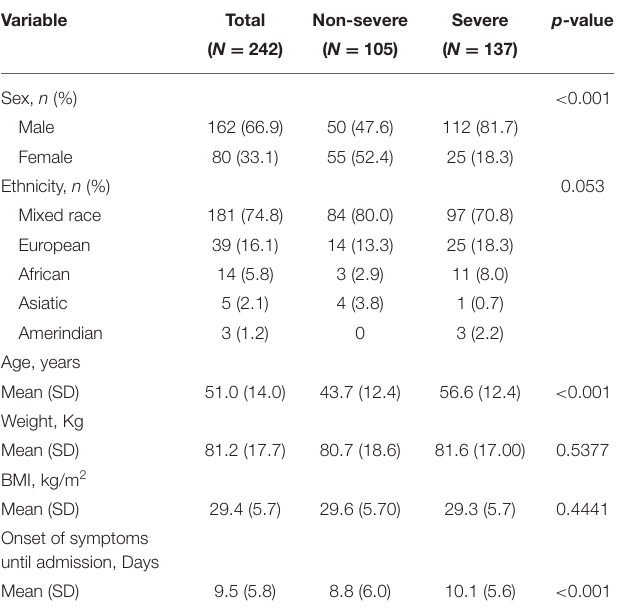
TABLE 1 | Demographics of patients at